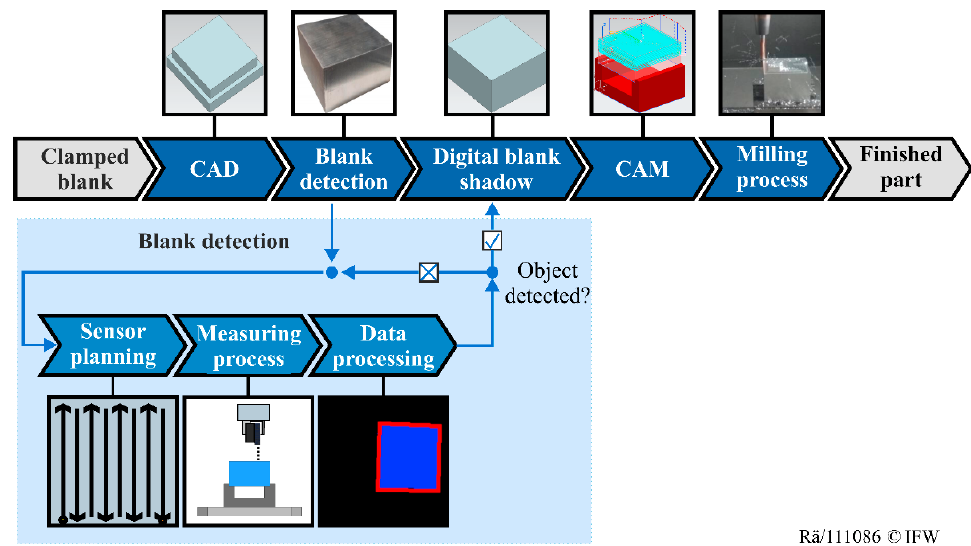
Figure 2. The investigated CAD/CAM chain with focus on blank detection.